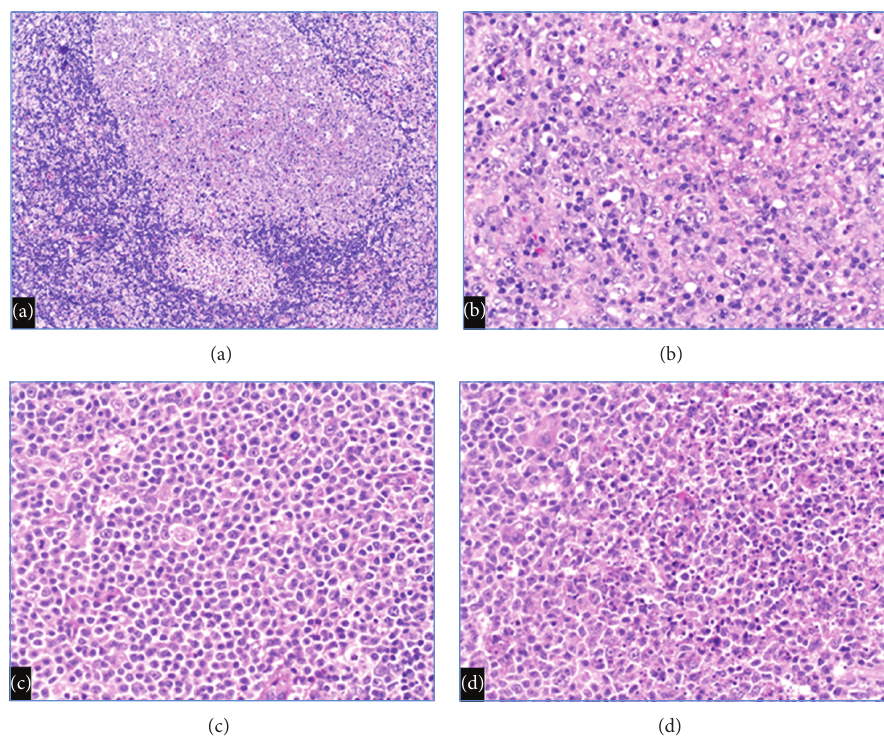
Figure 1: Histologic sections show (a) follicular hyperplasia with attenuated mantle zones and adjacent monocytoid B-cell hyperplasia (Case 1) 100x magnification, (b) paracortical hyperplasia with a moderate number of immunoblasts (Case 1) 200x magnification, (c) monocytoid B-cell hyperplasia (Case 1) 200x magnification, and (d) monocytoid B-cell hyperplasia with focal necrosis (Case 2) 200x